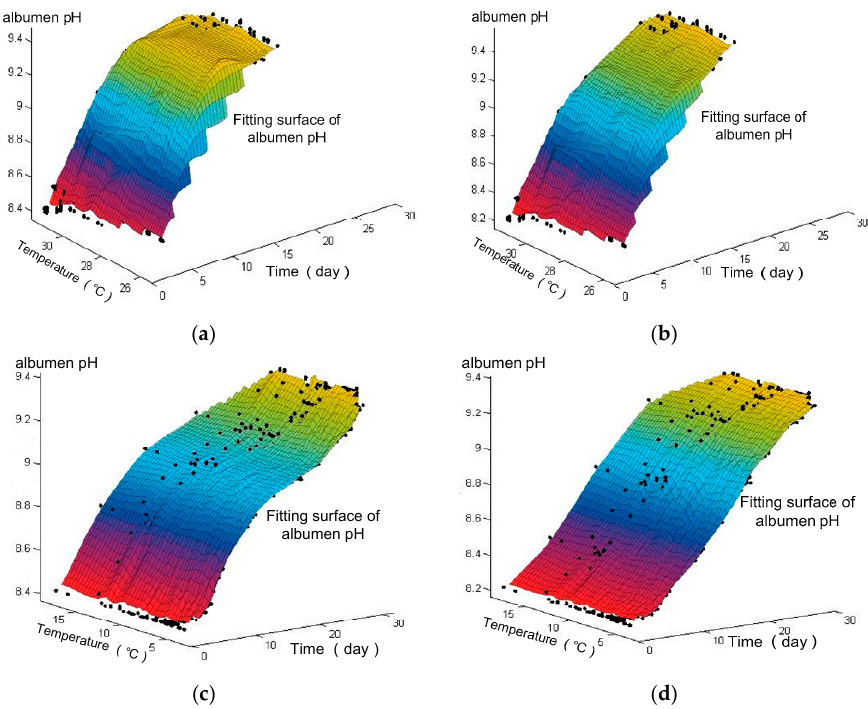
Figure 9. Albumen pH changes of n-3 PUFAs enriched and conventional eggs under different conditions. ( a ) Albumen pH changes of n-3 PUFAs enriched eggs under room temperature; ( b ) Albumen pH changes of conventional eggs under room temperature; ( c ) Albumen pH changes of n-3 PUFAs enriched eggs in refrigeration; ( d ) Albumen pH changes of conventional eggs in refrigeration.